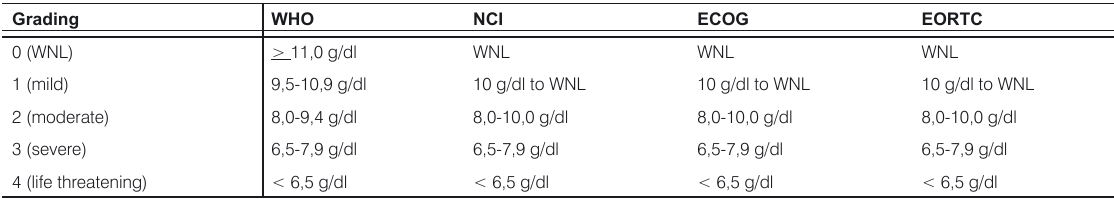
Table 2. Anemia severity criteria according to different Groups.